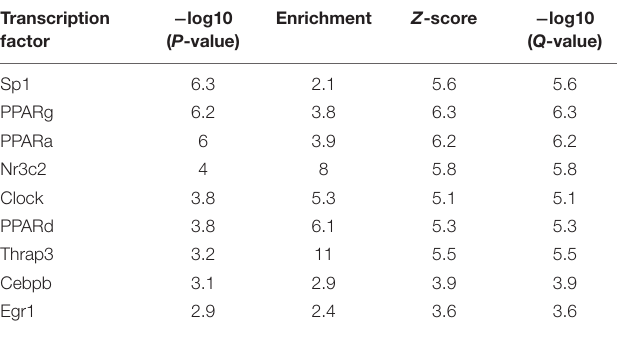
TABLE 3 | Top 10 transcription factor enriched in Metascape of